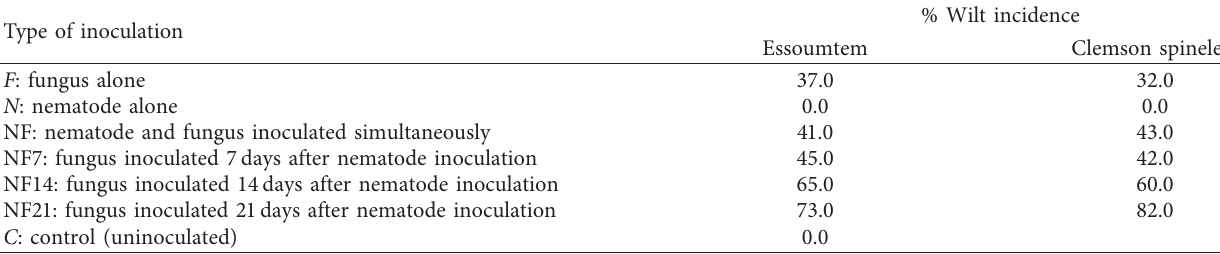
Table 8: Percentage wilt incidence for “Essoumtem” and “Clemson spineless” under various inoculations in pot experiment. Type of inoculation